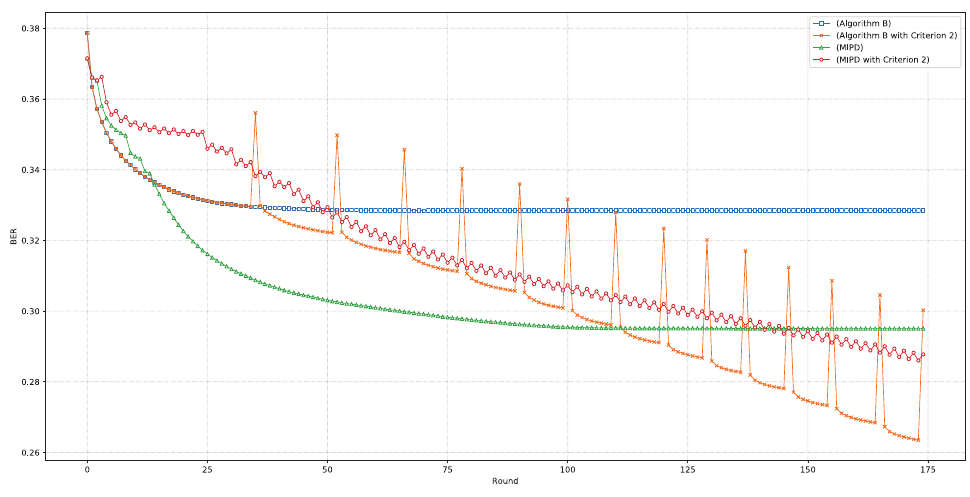
Figure 3: An example for comparing Criterion